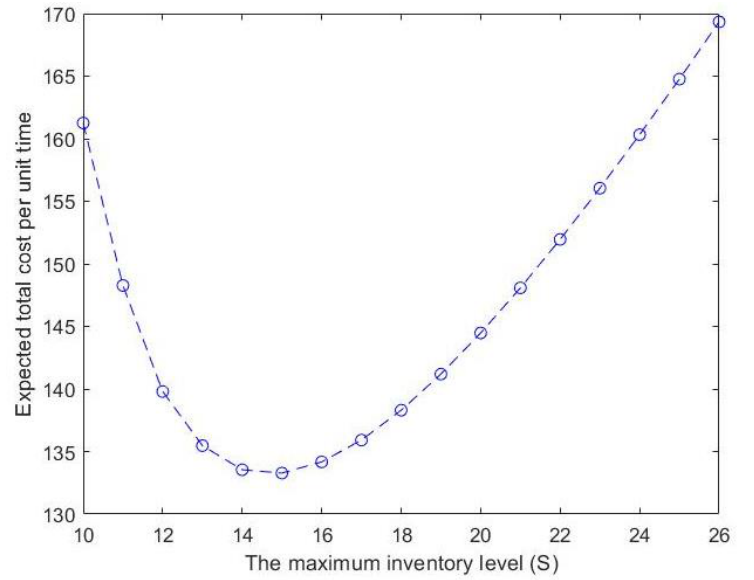
Figure 9. Effect of S on the expected total cost